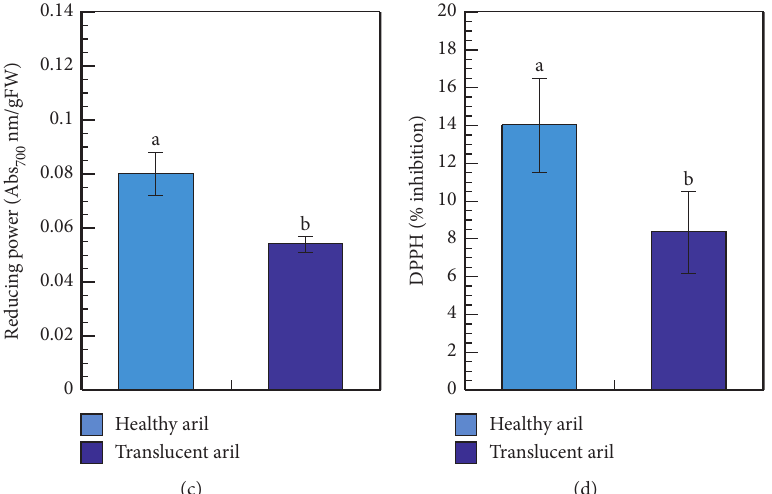
Figure 4: Ascorbic acid (a), flavonoid content (b), reducing power activity (c), and DPPH inhibition (d) in healthy and translucent arils. Means ( n � 4) with different lower-case letters on the bars are significantly different.